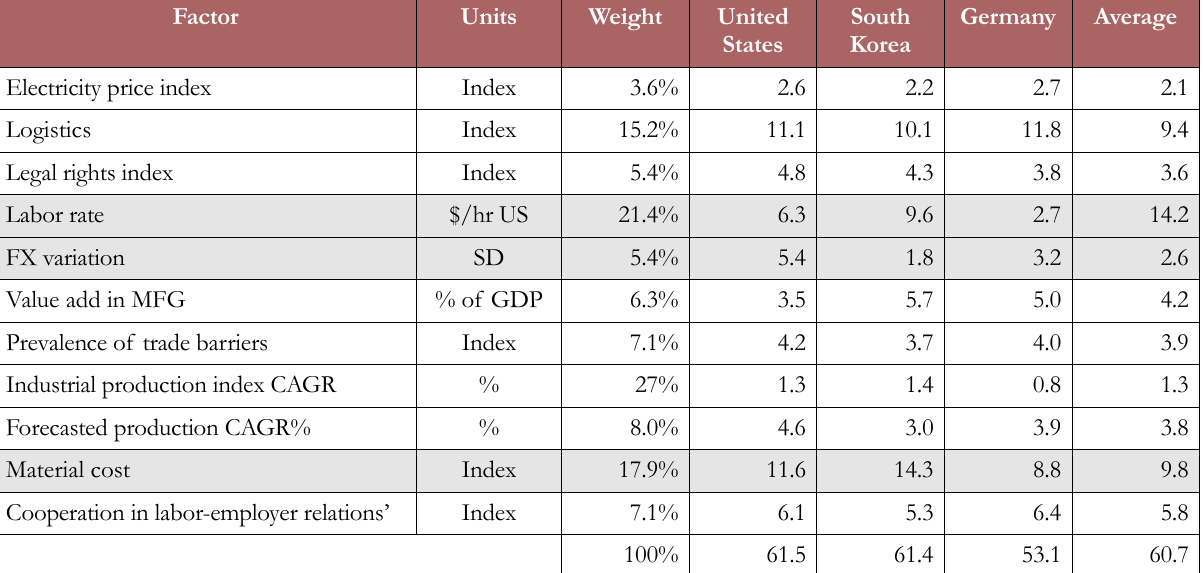
Table 15. United States, South Korea, and Germany